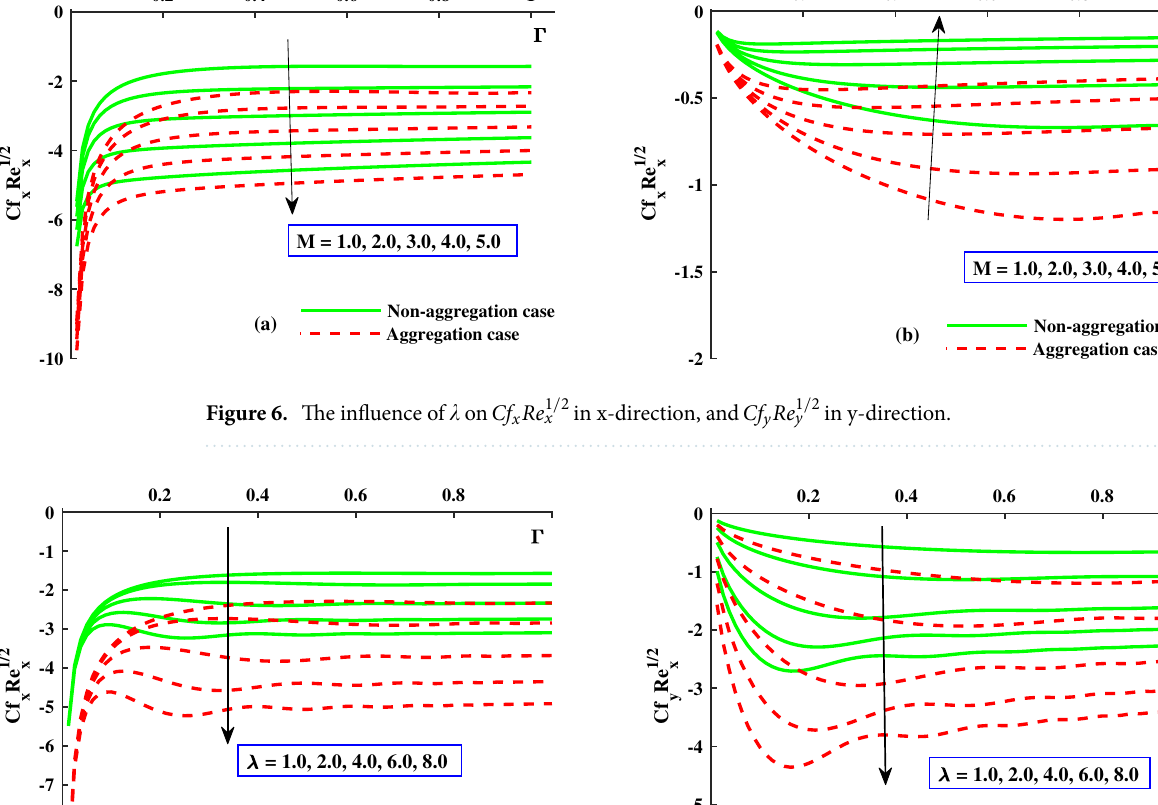
1 / 2 y in y-direction.